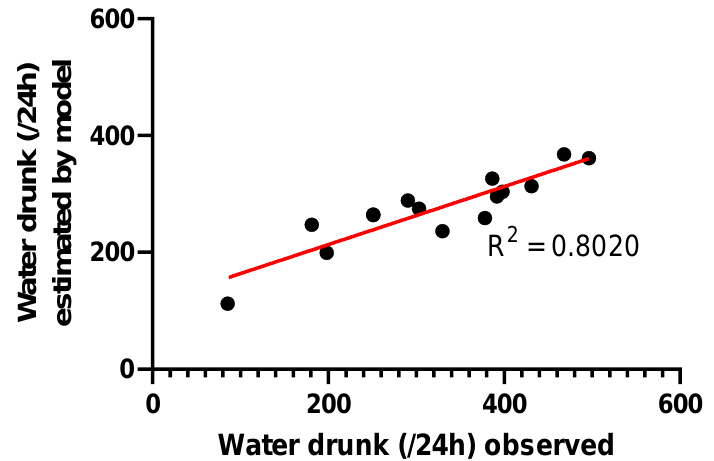
Figure 3. Correlation between the observed water consumption and the estimated water uptake by the model for 15 animals. The observed water drunk over 24 h was determined by adding the esti- mated proportion of nocturnal drinking (10.5%) to the water uptake evaluated during the photo- period. Coefficient of determination (R 2 ) =